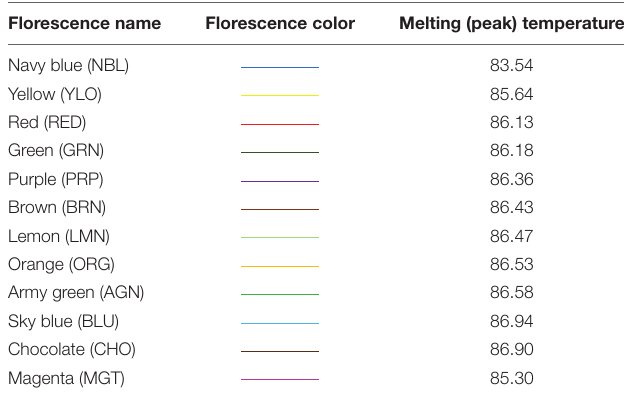
TABLE 1 | Heat shock protein ( HSP ) 70 gene variants/alleles at different melting